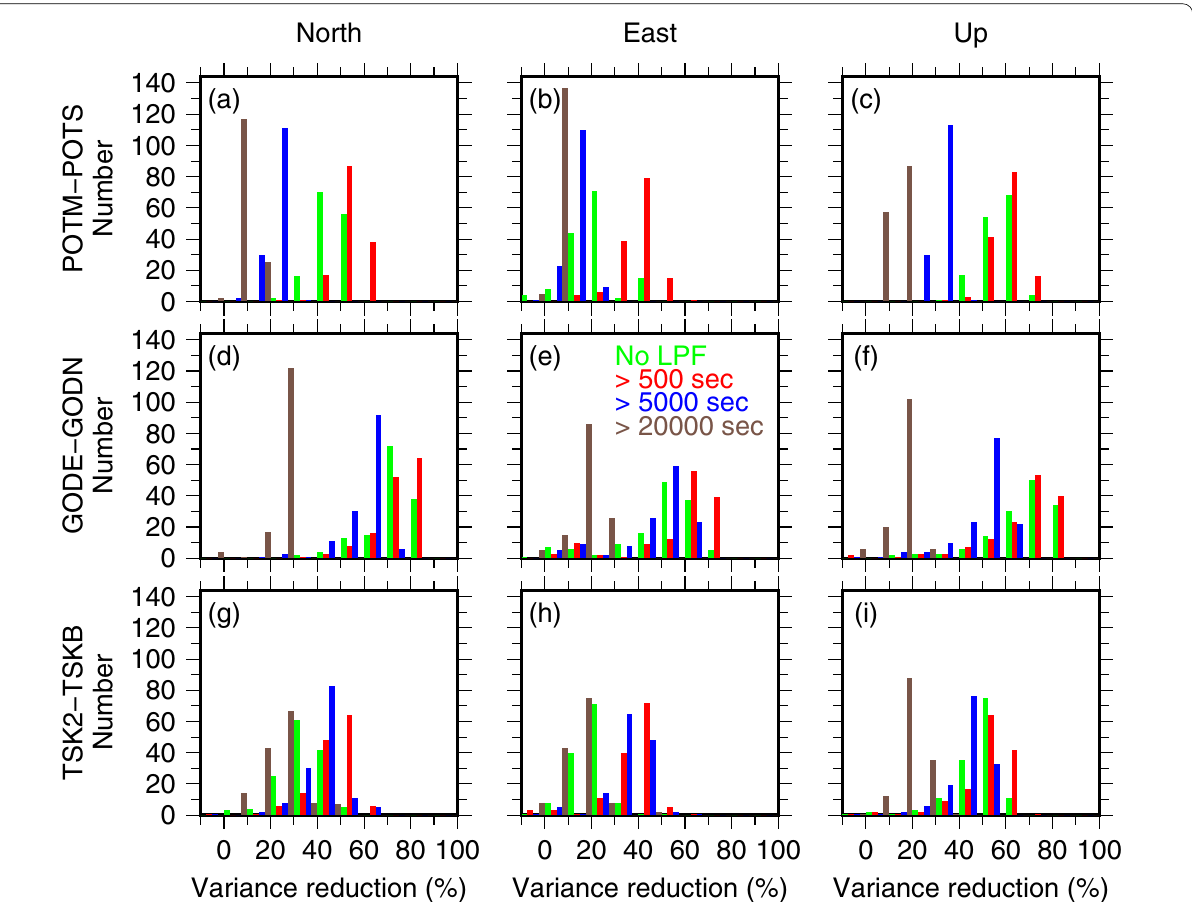
Fig. 7 Histograms of variance reduction by sidereal filtering. a – c Variance reduction using sidereal filter without (green) and with (others) low-pass filtering (LPF) for north ( a ), east ( b ), and up ( c ) components of a baseline POTM-POTS. A cut-off period for LPF is 500 (red), 5000 (blue), and 20,000 (brown) seconds. d – f Same as a – c but for a baseline GODE-GODN. g – i Same as a – c but for a baseline